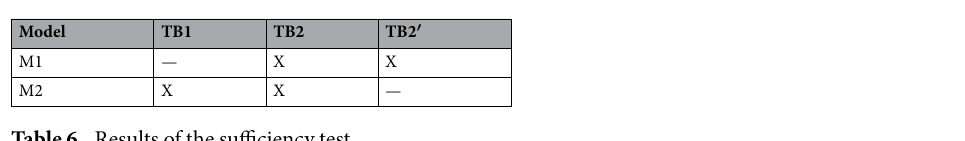
Table 6. Results of the sufficiency test.